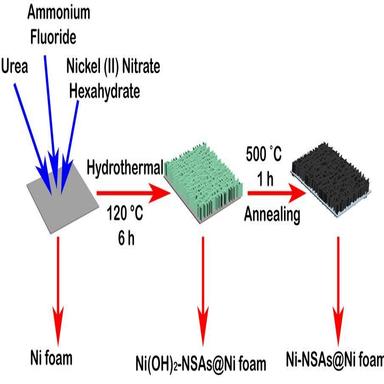
Schematic fabrication process of 3D porous Ni-NSAs@Ni foam.